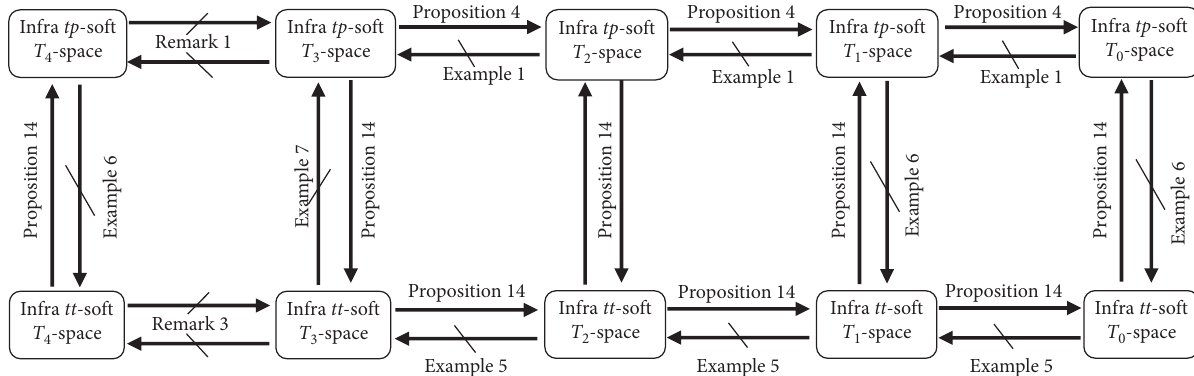
Figure 1: The relationships between infrasoft separation